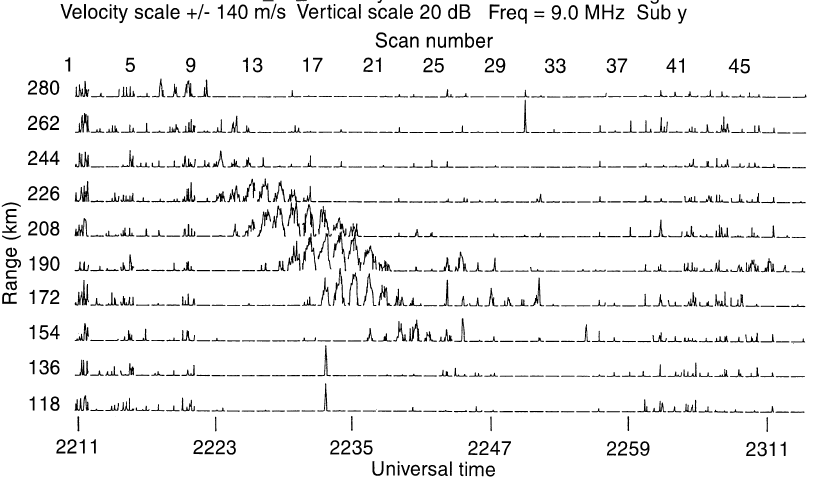
Fig. 4. Time evolution of E-region aspect sensitive echoes at 9 MHz in azimuth 10 (cid:176) W, in the time-period 2211–2314 UT. The Doppler spectrum at any cell is logarithmic on a 20-dB scale with the Doppler velocity ranging from - 140 to 140 m/s. A scattering region forming a band with a negative range rate of about 90– 110 m/s is observed between 2223 and